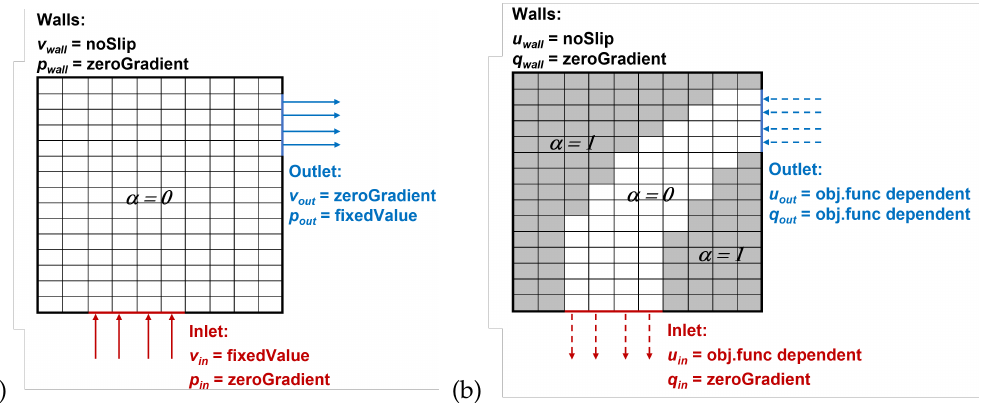
Figure 1. Topology optimization setup: available design space for a duct flow configuration ( a ) and the topology optimization outcome ( b ), with respective boundary